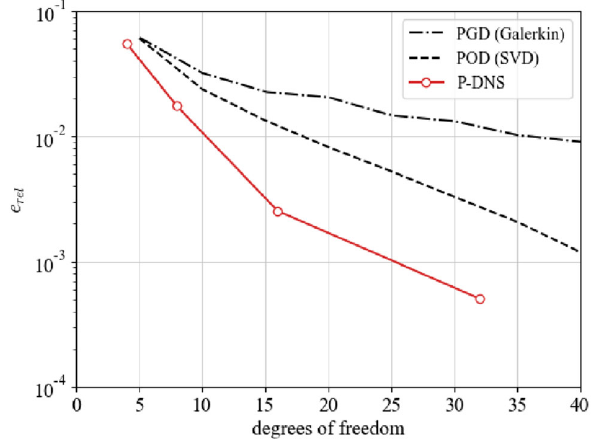
Fig. 7 The Idelsohn’s benchmark. Relative error varying the degrees of freedom. In the case of ROM solutions, DOF is the number of modes. For P-DNS, DOF is the number of nodes of the coarse